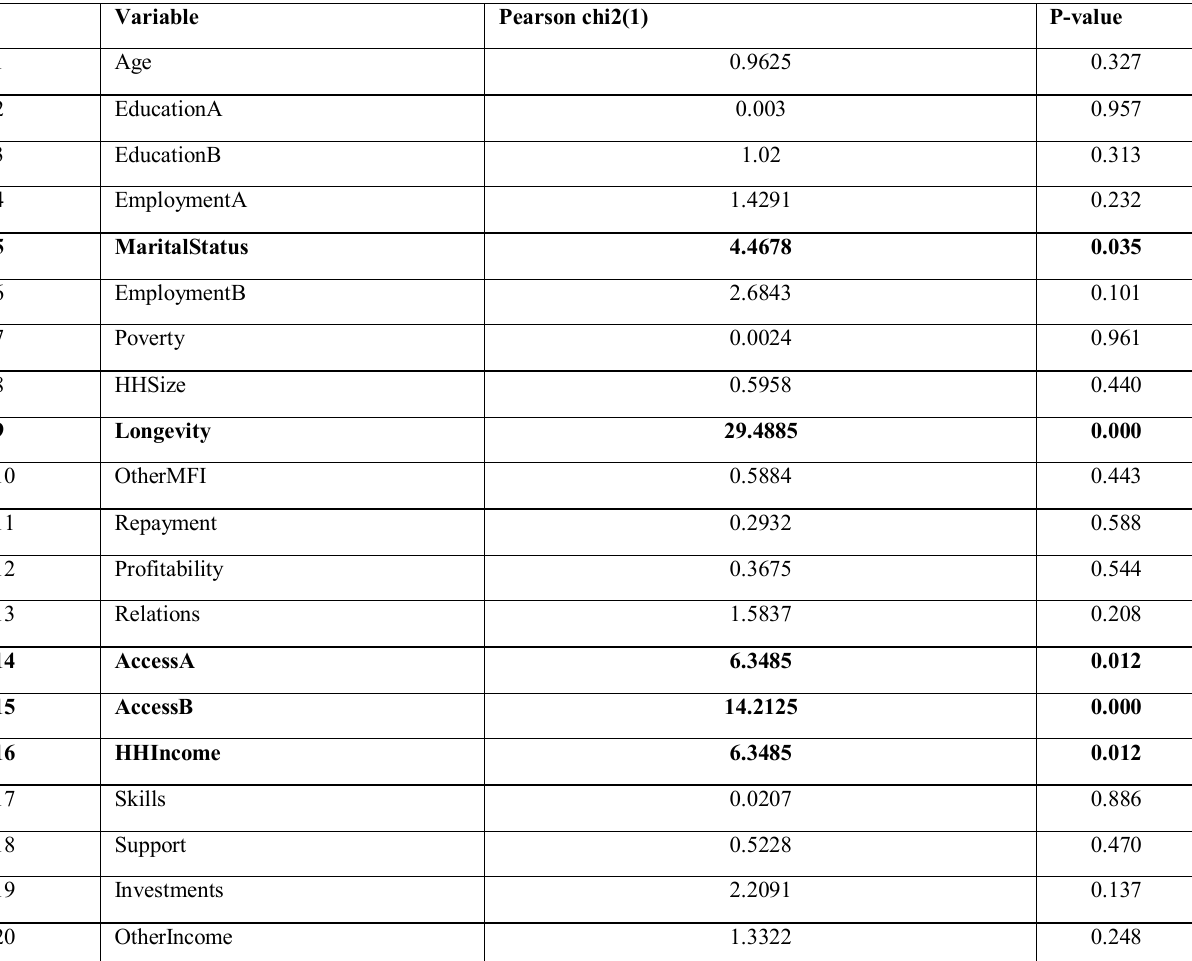
Table 3: Pearson’s chi square test for ownership against each of the selected independent variables